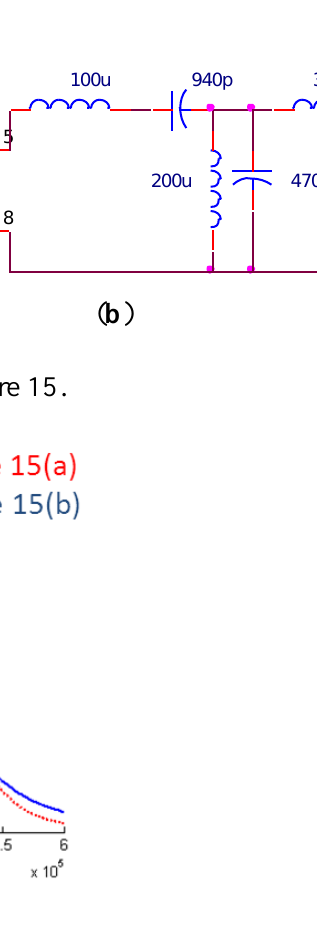
Figure 15. Topologies that the transformer turns ratio is 1:2 ( a ) RFT; ( b ) algorithm